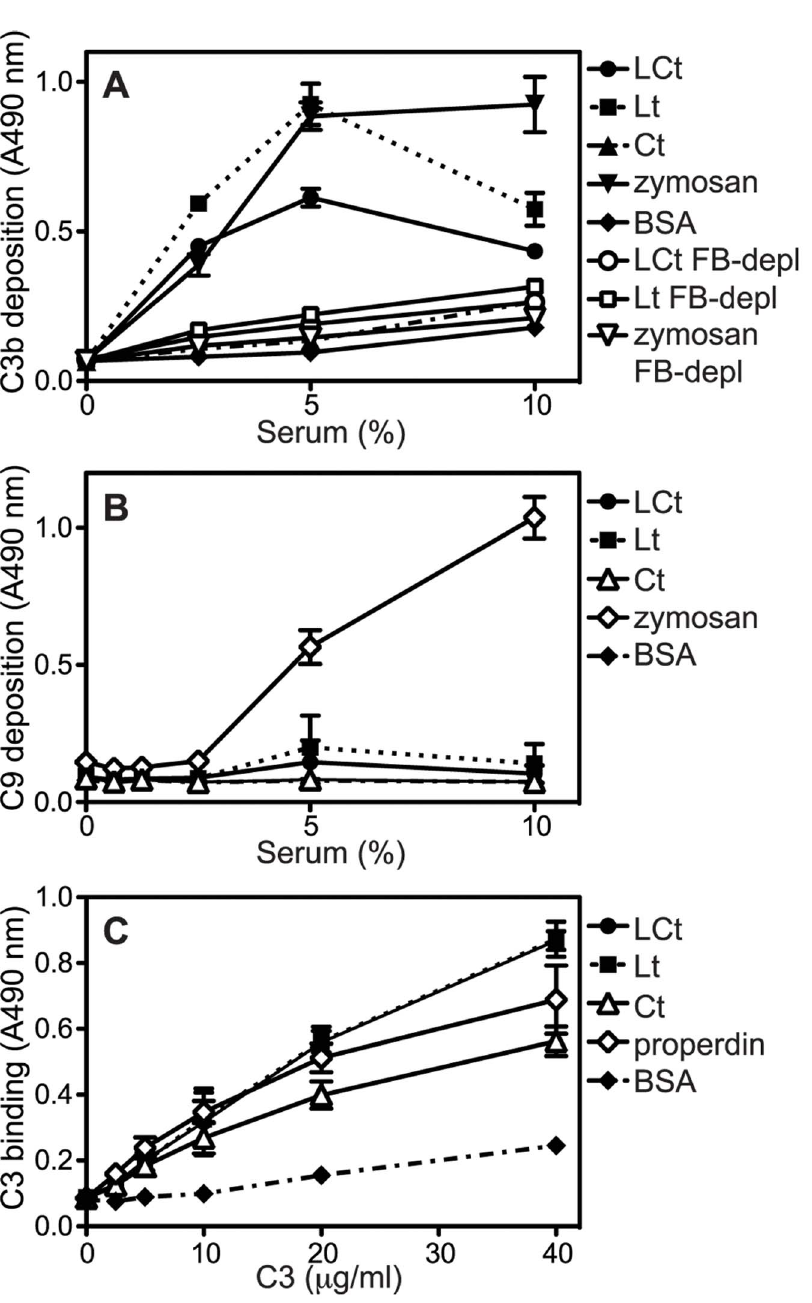
Figure 6. Lectin domain of aggrecan G3 module triggers limited activation of the alternative pathway. Zymosan (positive control for alternative pathway), LCt, Lt, Ct and BSA (negative control) were coated onto microtiter plates and increasing concentrations of NHS or factor B- depleted (FB-depl) human serum in Mg ++ EGTA were added. Activation of the alternative pathway was measured by detecting deposited C3b ( A ) and C9 ( B ). Properdin (positive control for binding of C3), LCt, Lt, Ct and BSA (negative control) were coated onto microtiter plates and incubated with purified C3, which was then detected with specific antibodies ( C ). The graphs show the mean and SD of three independent experiments.